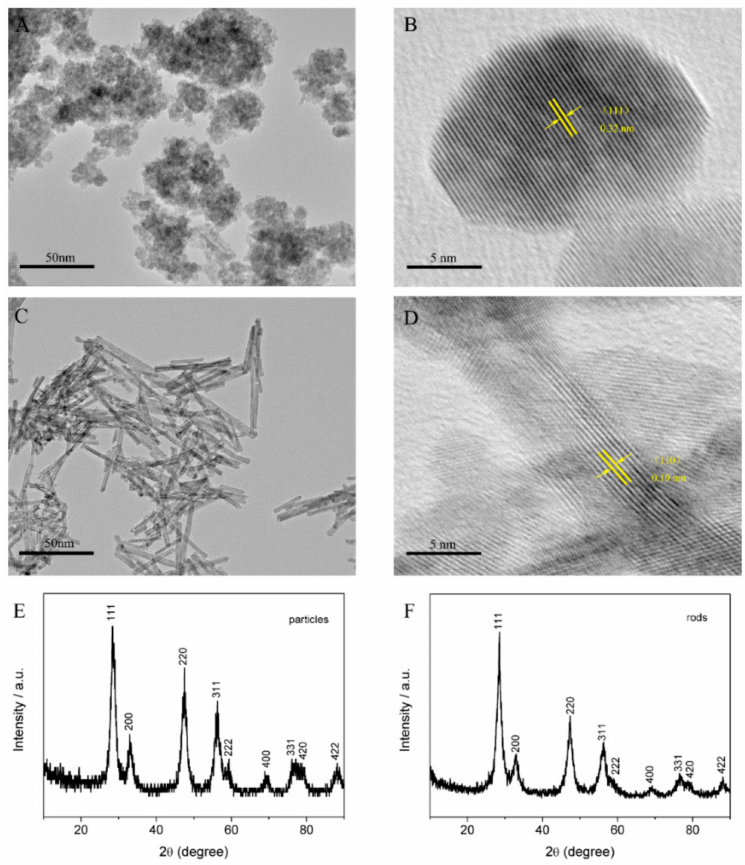
Figure 1. TEM and HRTEM images of CeO 2 : nanoparticles ( A , B ); and nanorods ( C , D ). XRD pattern of CeO 2 : nanoparticles ( E ); and nanorods ( F